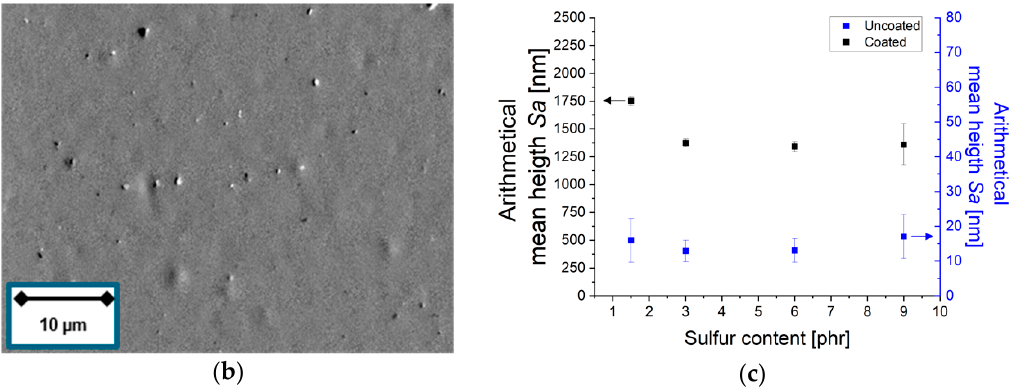
Figure 6. ( a ) 1.5 phr surface condition before Ar pretreatment; ( b ) 1.5 phr surface condition after Ar pretreatment; ( c ) arithmetical mean height Sa of uncoated and coated NBR samples at different sulfur content.